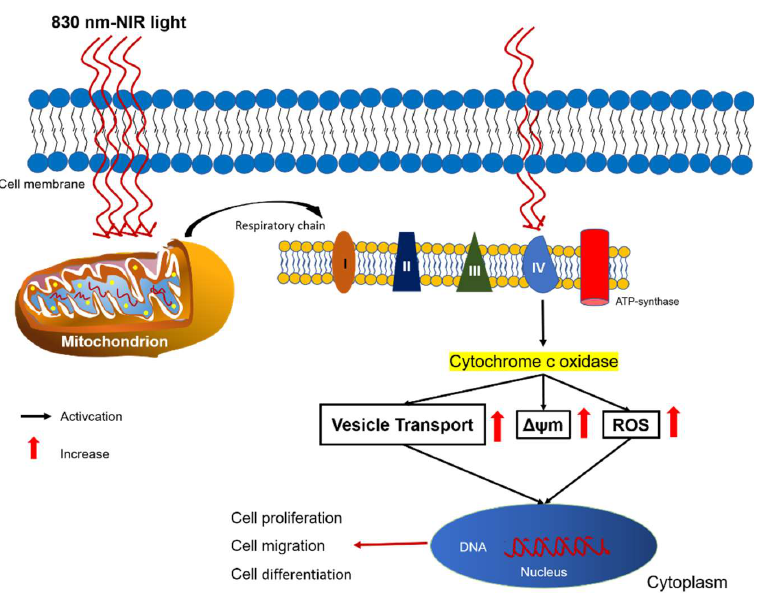
Figure 1. Schematic diagram for mechanisms of photobiomodulation. Cytochrome c oxidase (CCO) is a major photoreceptor, located in the mitochondrial respiratory chain at unit IV in the mitochondria, was released by PBM, followed by a functional change in the original mitochondrial respiratory chain to generate ROS and increased mitochondrial membrane potential (ΔΨm) that plays a crucial role in ATP production through oxidative phosphorylation.